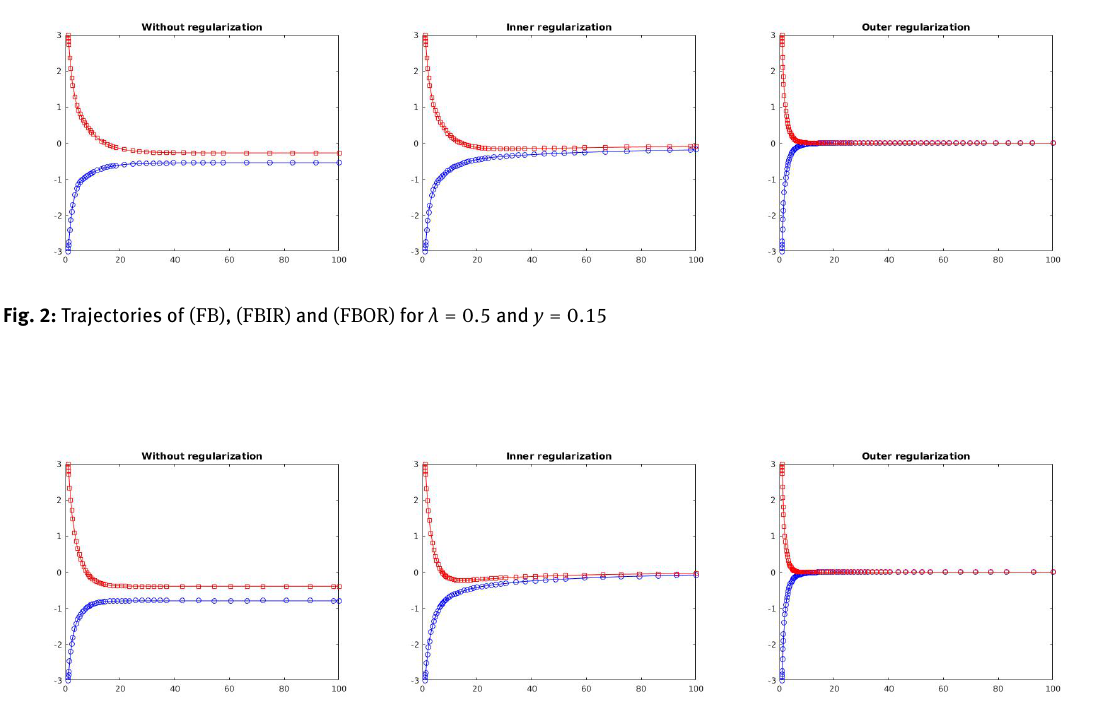
Fig. 3: Trajectories of (FB) , (FBIR) and (FBOR) for λ = 0.5 and γ = 0.3